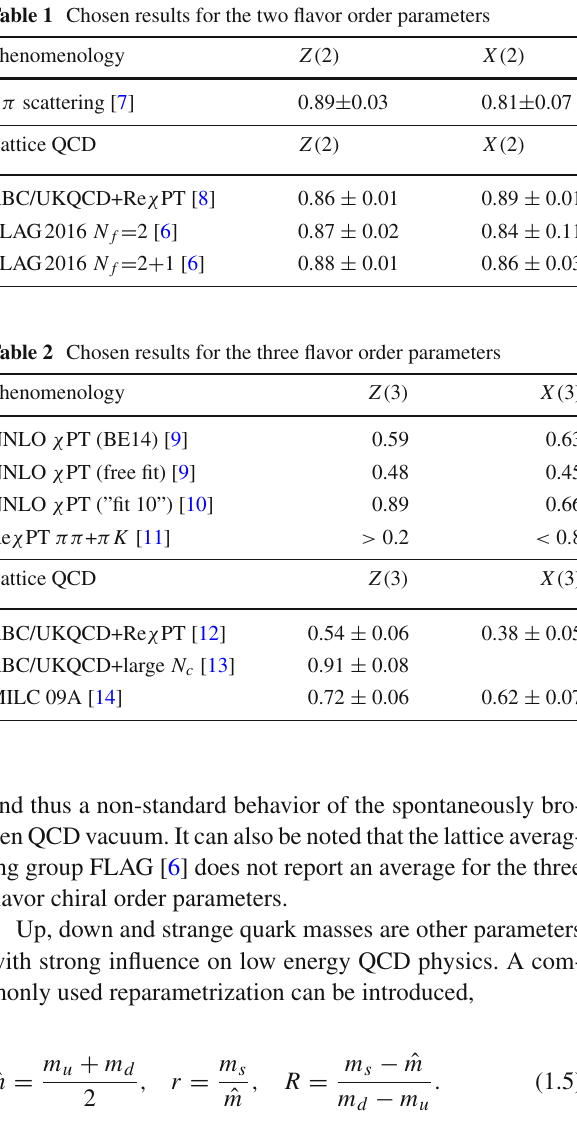
Table 3 Chosen results for the isospin breaking parameter R . r